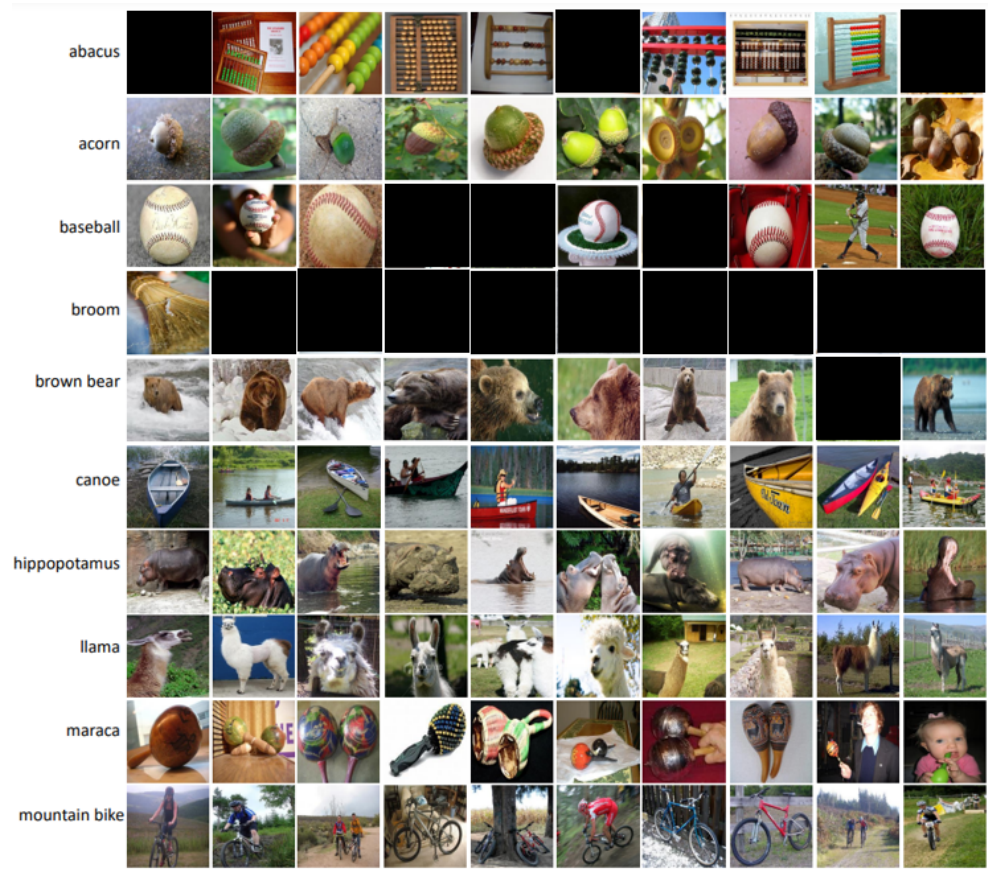
( A p ) and D BIM ( A p ) . q q k k ) is , c t q q for which EA target, C k created q for which BIM k created 0.999- q